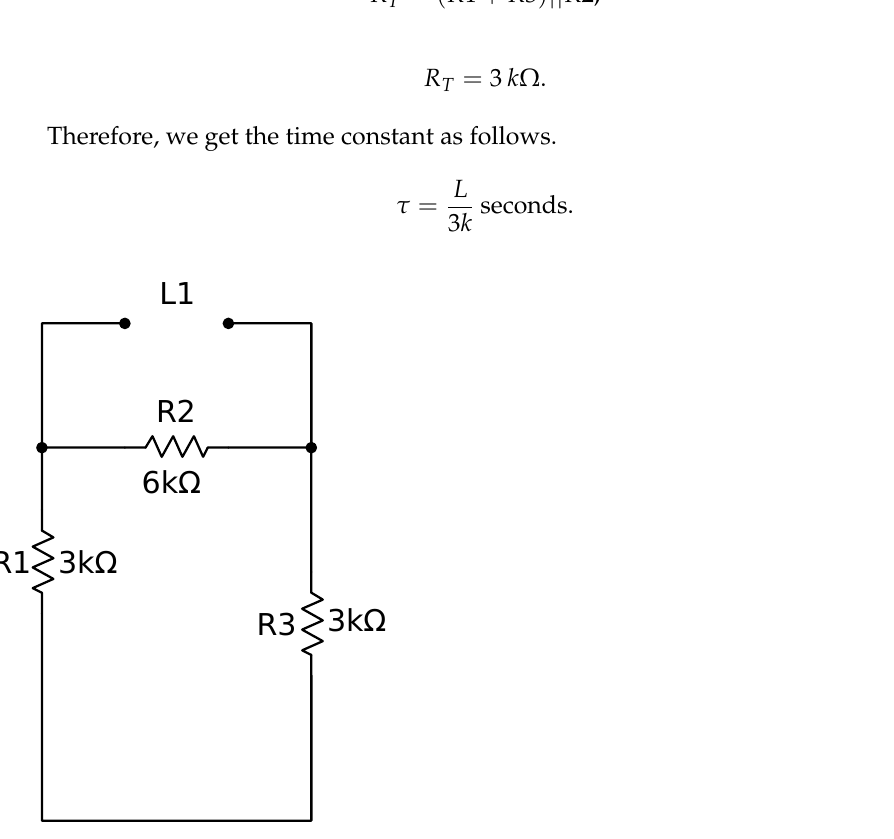
Figure 5. The circuit to calculate the Thevenin equivalent resistance across the inductor terminals at t > 0. The voltage source V2 has been turned